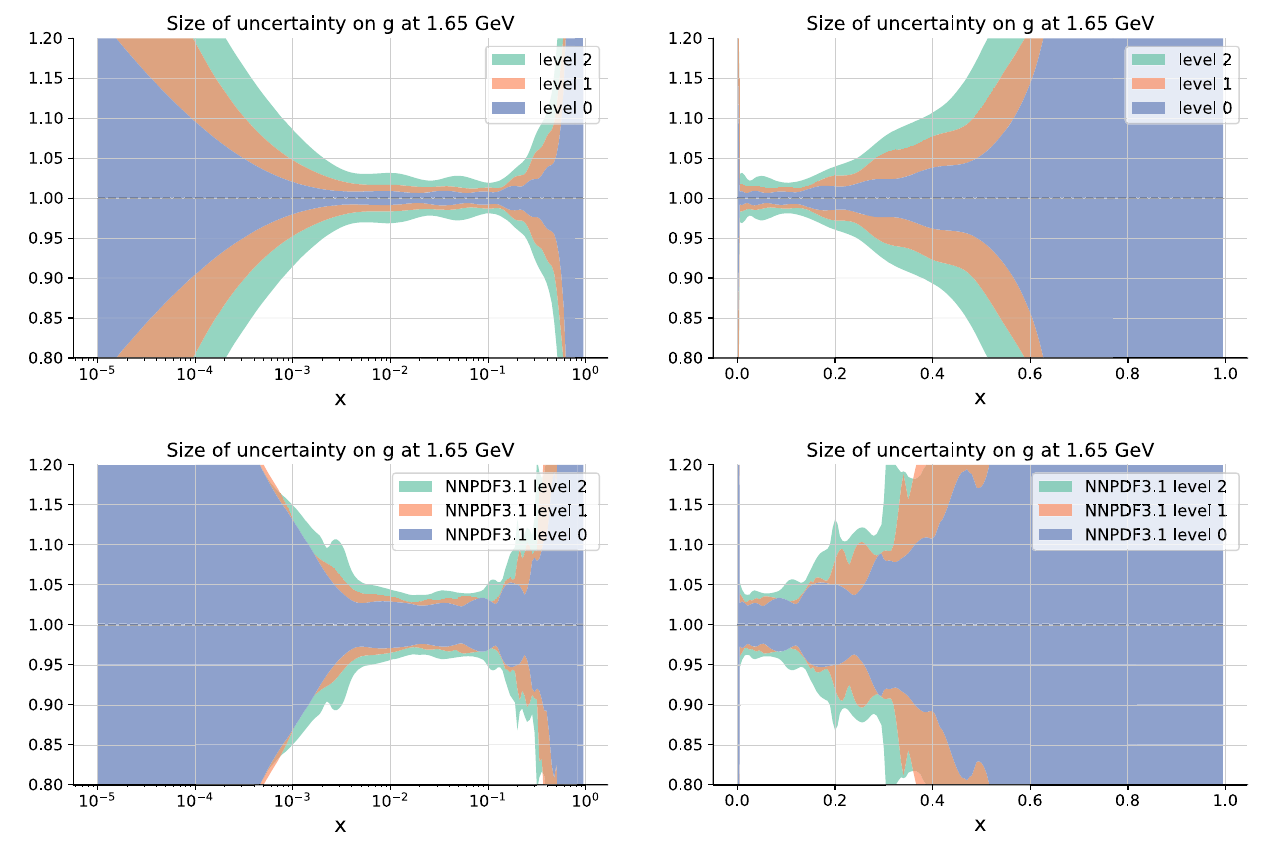
Fig. 5 Relative PDF error for the gluon distribution in the NNPDF4.0 (upper panel) and NNPDF3.1 (lower panel) methodology, plotted in logarithmic (left) and linear scale (right)